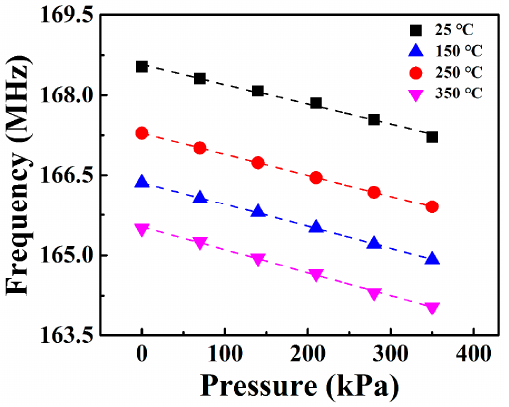
Figure 9. The peak frequency of the sensor versus pressures (0–350 kPa) under different measuring temperatures (25–350 °C).